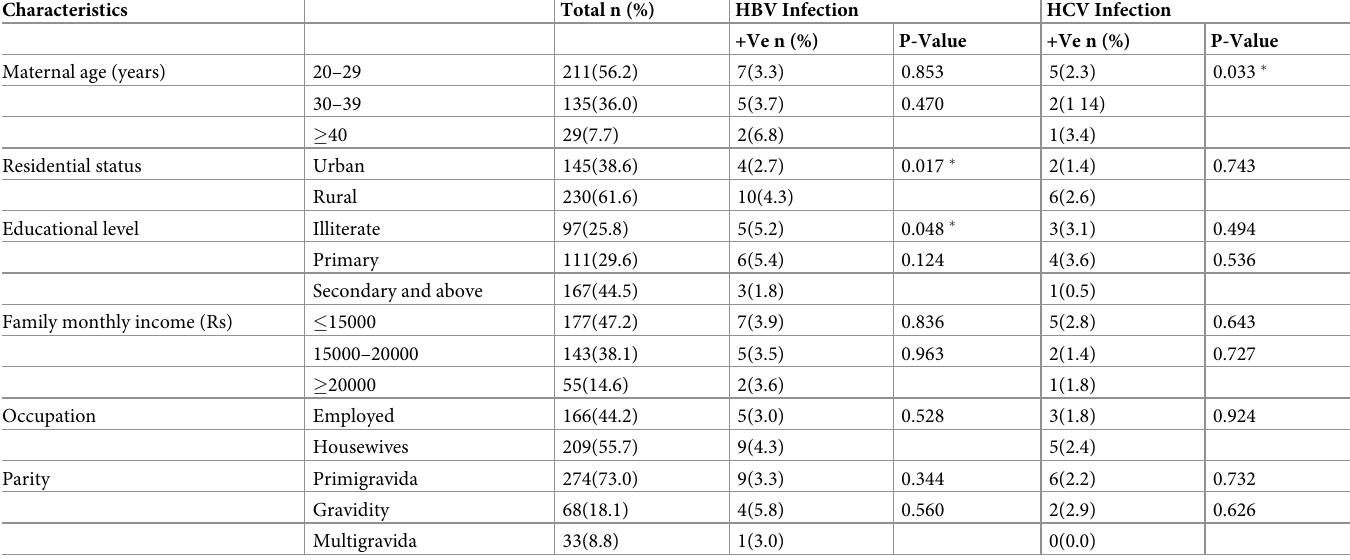
Table 2. Prevalence of HBV and HCV infection in association to sociodemographic characteristics of pregnant women attending maternity wards at selected Hospi- tals, DHQ Hospital Swabi and BKMC Shahmansoor.